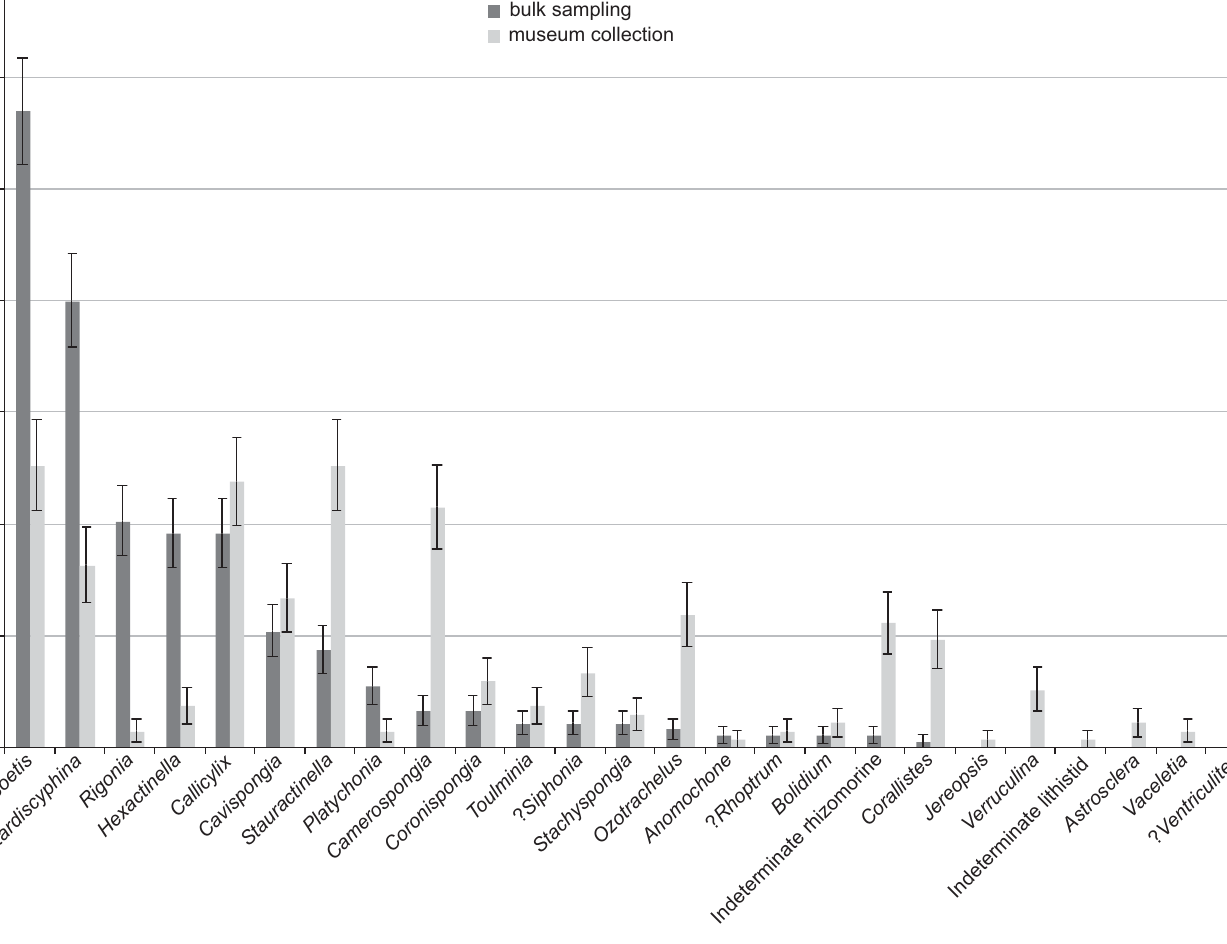
Fig. 8. Distribution of sponge genera from museum collections (data from Frisone et al. 2016) and bulk sampling (this study). Error bars denote binomial standard errors of